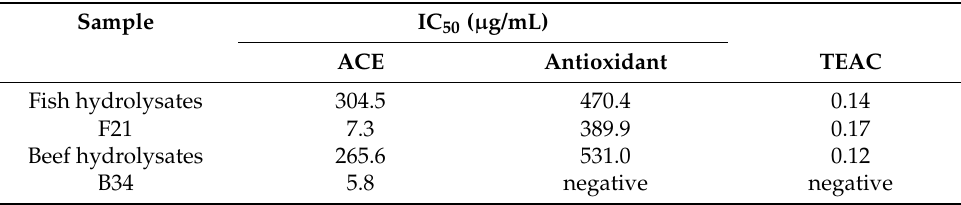
Table 2. ACE inhibitory activity and antioxidant properties of the hydrolysates F21 and B34. Sample Fish hydrolysates Beef